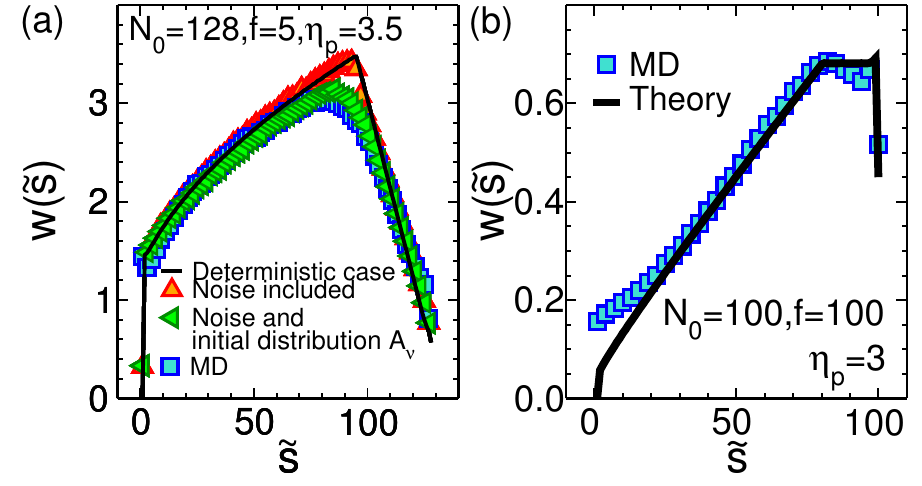
Figure 9. ( a ) The waiting time (WT) w ( ˜ s ) as a function of ˜ s for the pore-driven case. The chain length is N 0 = 128, the external driving force at the pore is f = 5, and the pore friction in the IFTP theory is η p = 3.5. The black curve presents the deterministic case with fixed A ν = 1.15, where neither the thermal fluctuations nor the distribution of the initial configurations of the chain have been taken into account. The red up triangles show the WT when the force is sampled from the proper distribution but A ν = 1.15 is deterministic. Green left triangles are the WT data when both the force and A ν have been sampled from their distributions, and finally MD simulation data are blue squares. ( b ) The same as ( a ) but for the end-pulled case. Black curve is for deterministic case while the blue squares represent the MD simulation data. Here, the chain length is N 0 = 100, the external driving force is f = 100, and the pore friction in the IFTP theory is η p =